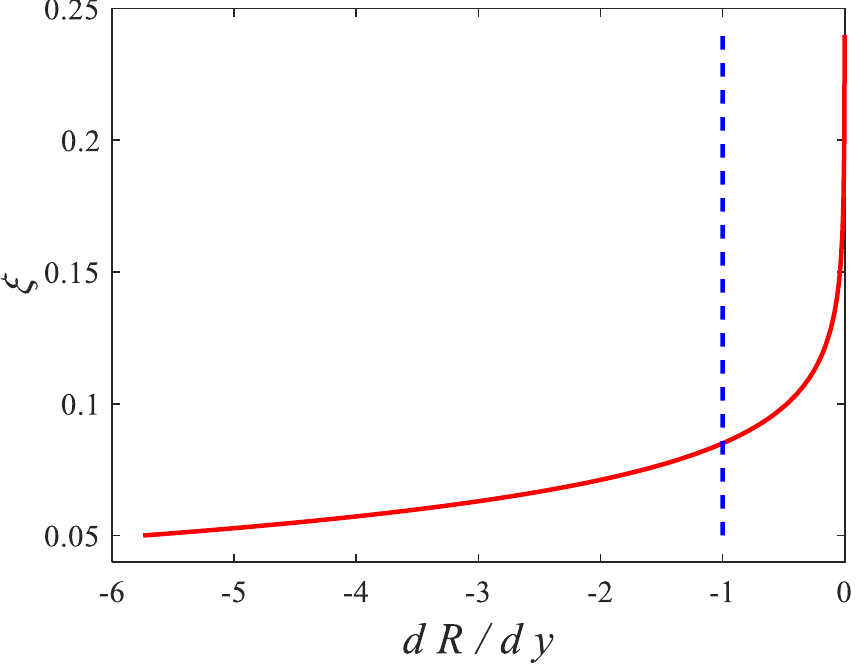
Figure 6. First criterion for concentration profiles shape. Vertical distribution of the derivative of the ratio between sediment diffusivity and settling velocity R; concentration profile is upward convex for dR < − 1 while it is upward concave for dR > − dy